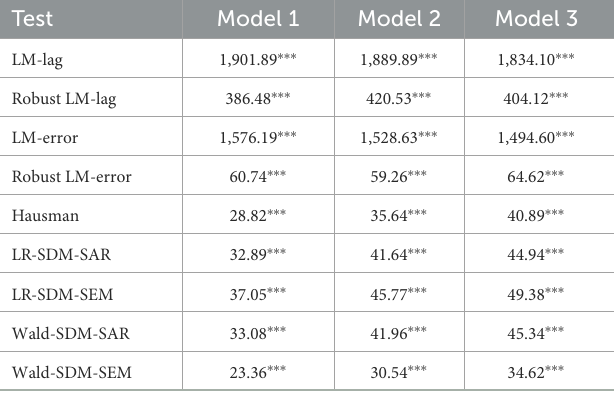
TABLE 4 Spatial metrological inspection. TABLE 5 Spatial measurement results of VER on GDE.